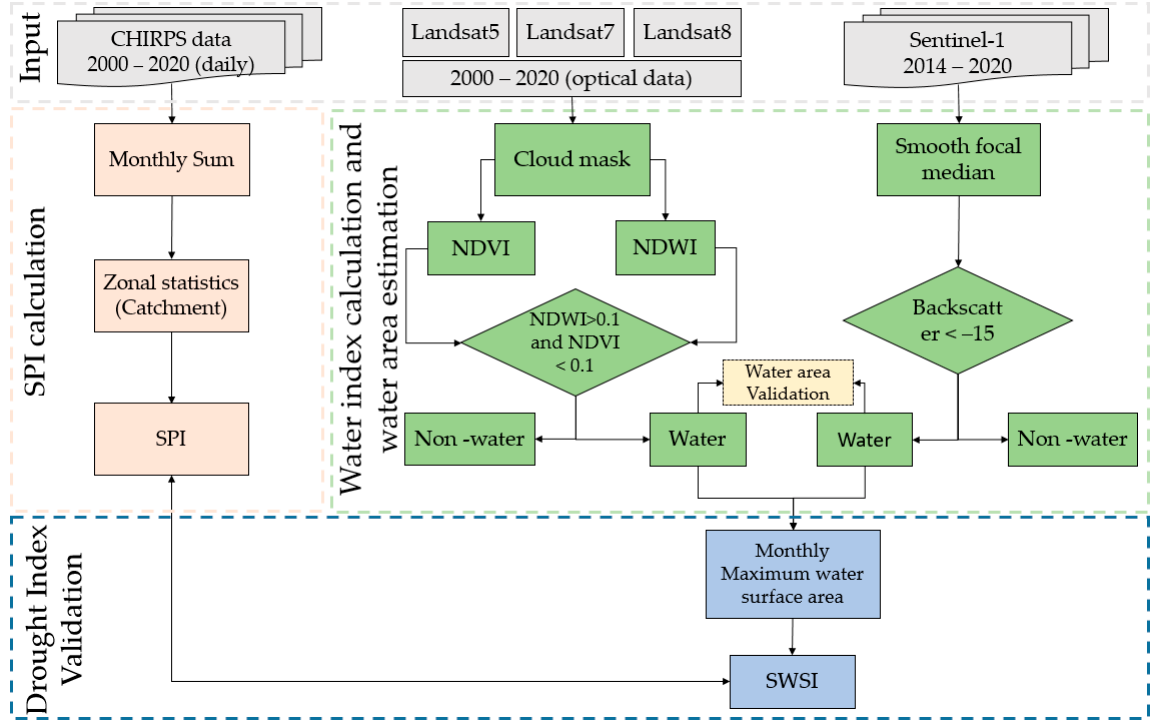
Figure 2. Flow chart that reflects the overall methodology followed in this study.